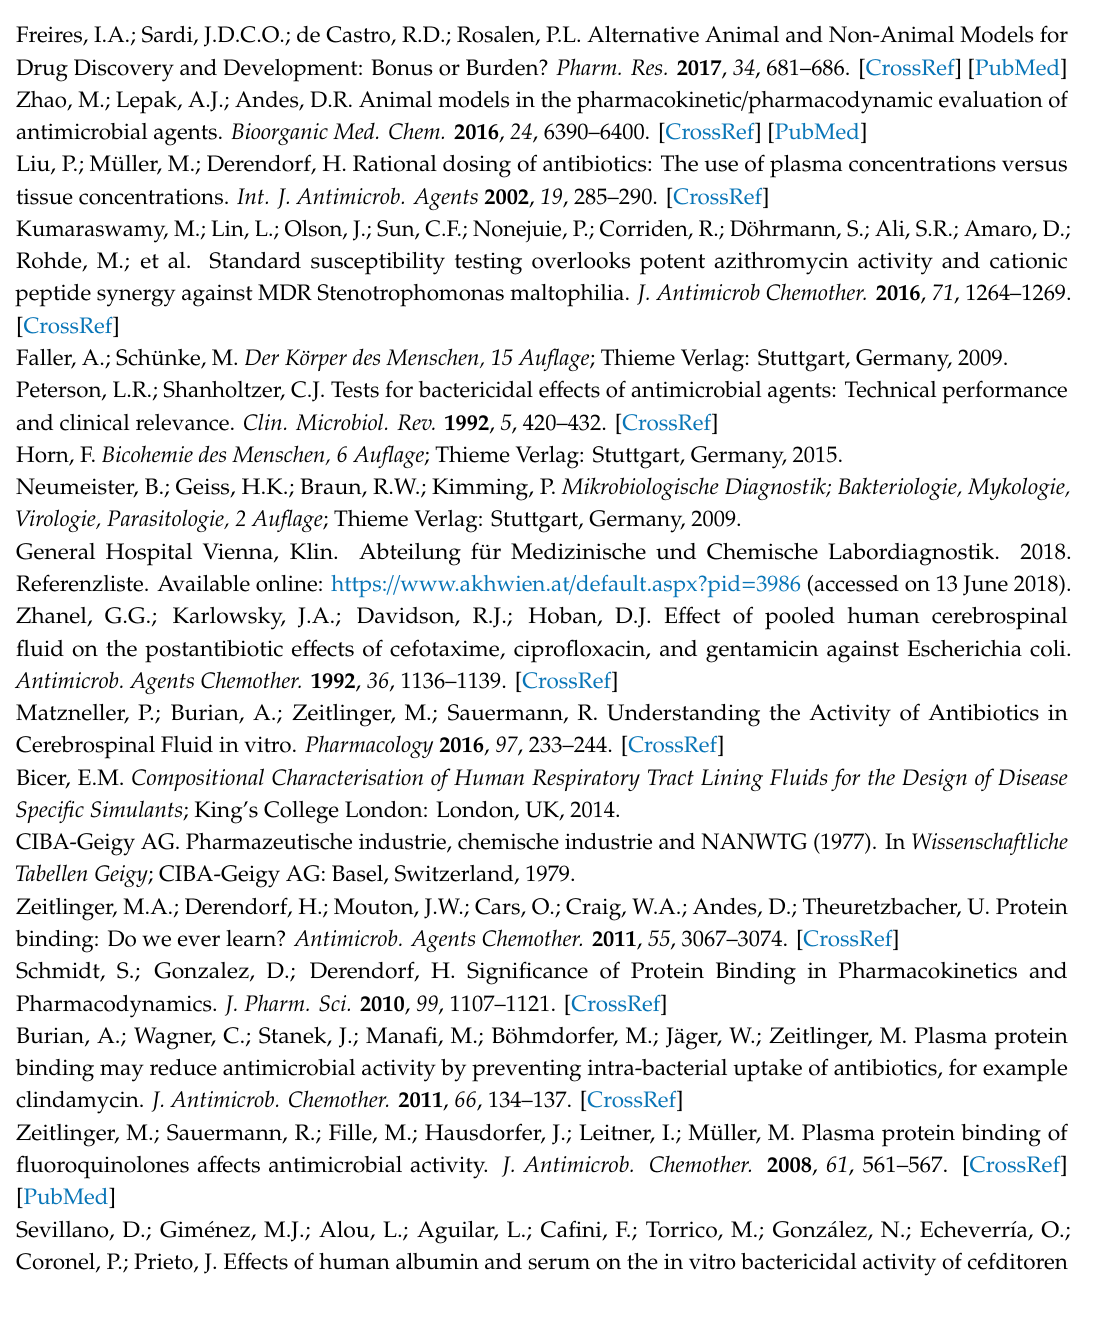
Table S1: Antibiotic susceptibility testing in adjusted growth media and in body fluids, and their impact on antibiotic